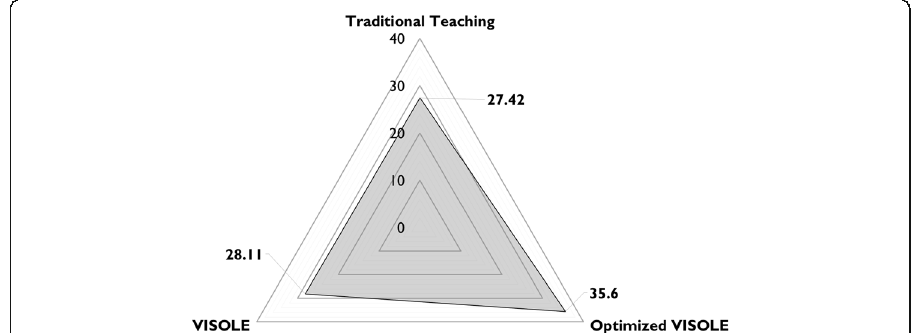
Fig. 3 Overall comparison on knowledge test mean scores obtained at School B